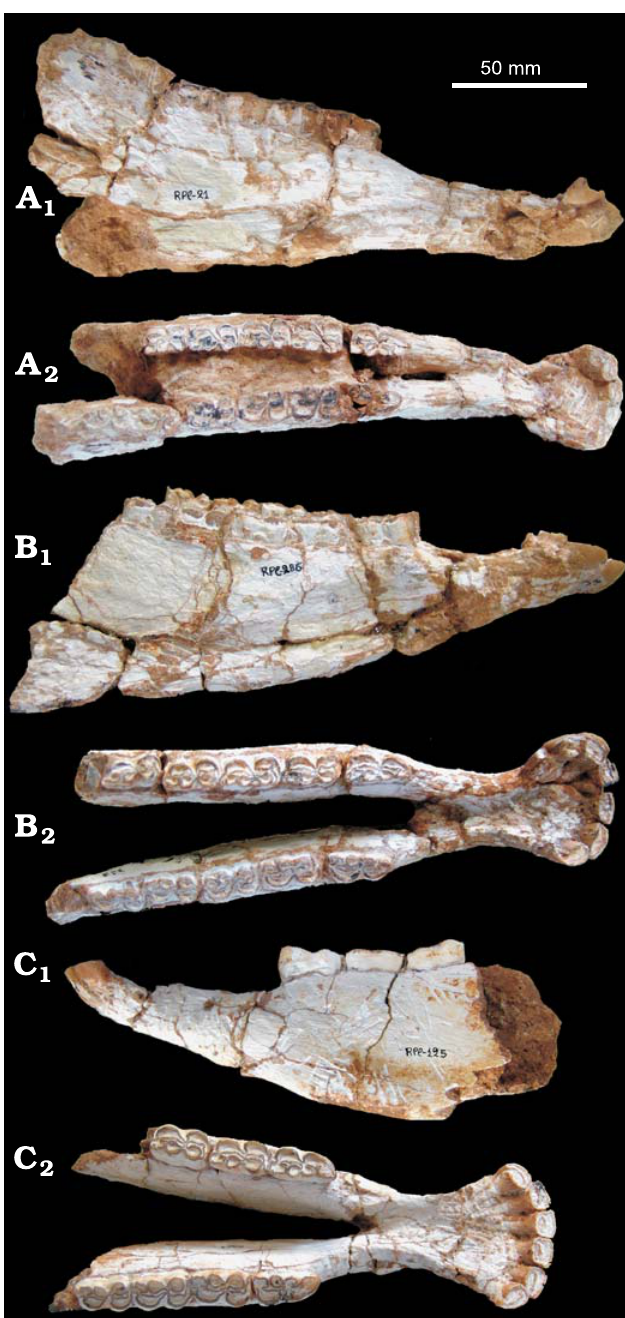
Fig. 3. Equid Hipparion macedonicum Koufos, 1984 from Ravin de la Pluie, Axios Valley (Mace donia, Greece), late Vallesian, MN 10 (Late Miocene). A . Holotype LGPUT RPl-21, mandible in right lateral (A 1 ) and occlusal (A 2 ) views. B . LGPUT RPl-286, mandible in right lateral (B 1 ) and occlusal (B 2 ) views. C . LGPUT RPl-125, mandible in left lateral (C 1 ) and occlusal (C 2 )